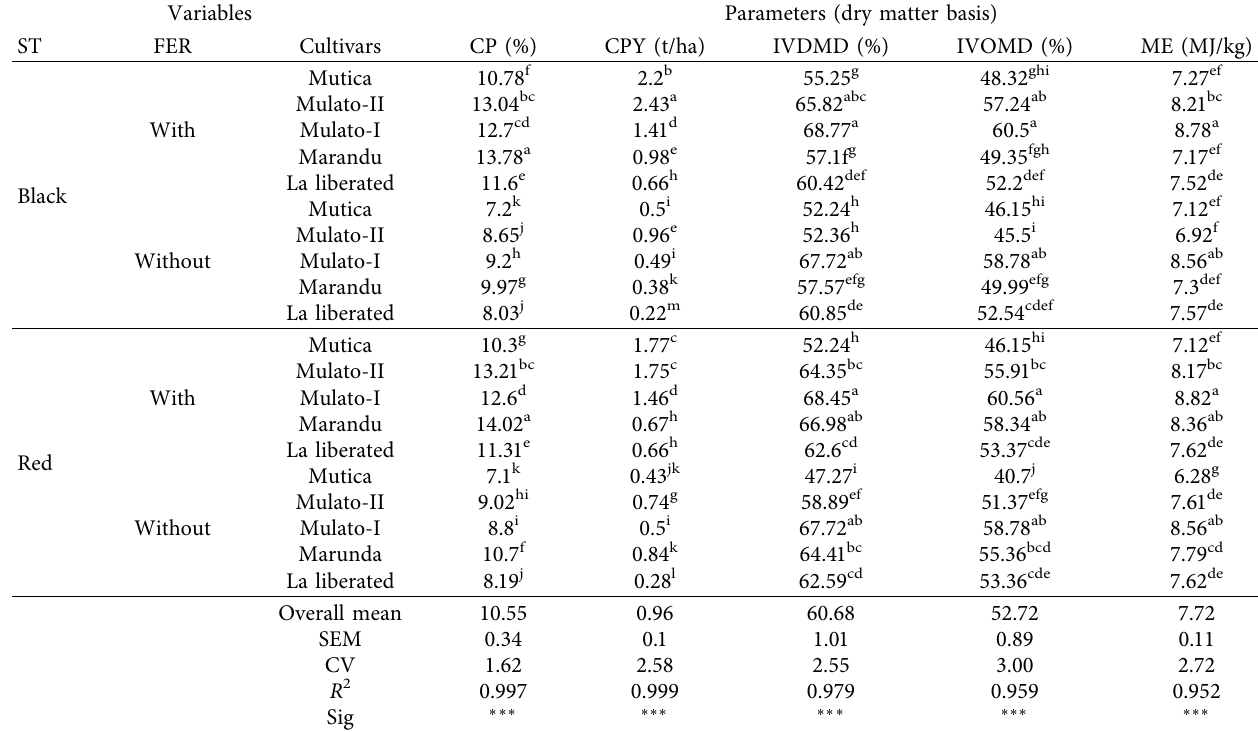
Table 4: Efect of fertilizer, soil type, and cultivars on nutritive values of Brachiaria grasses.